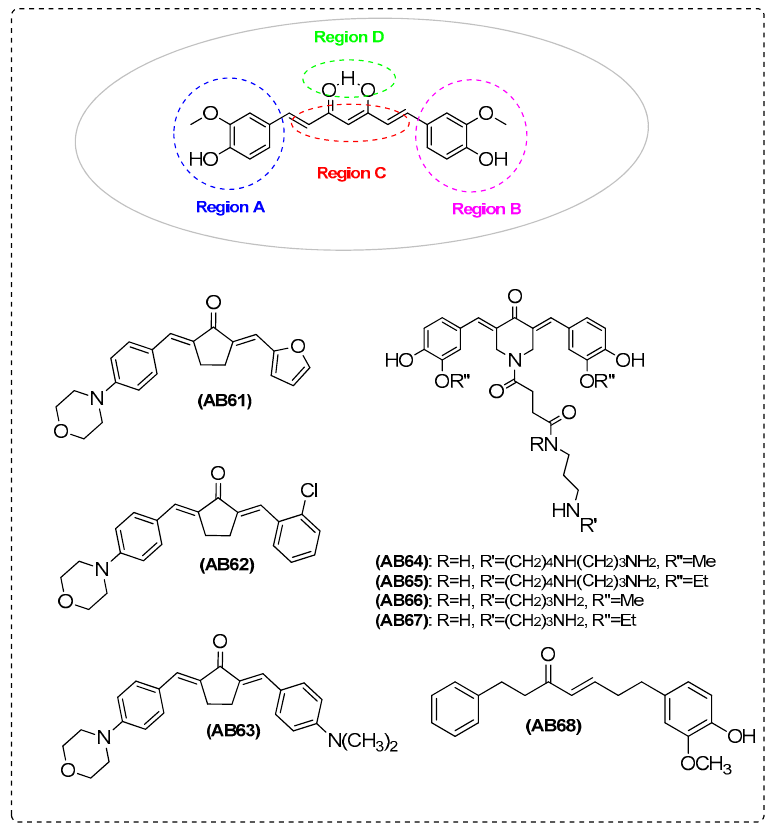
Figure 10. inhibitors. Figure 10. Antioxidant